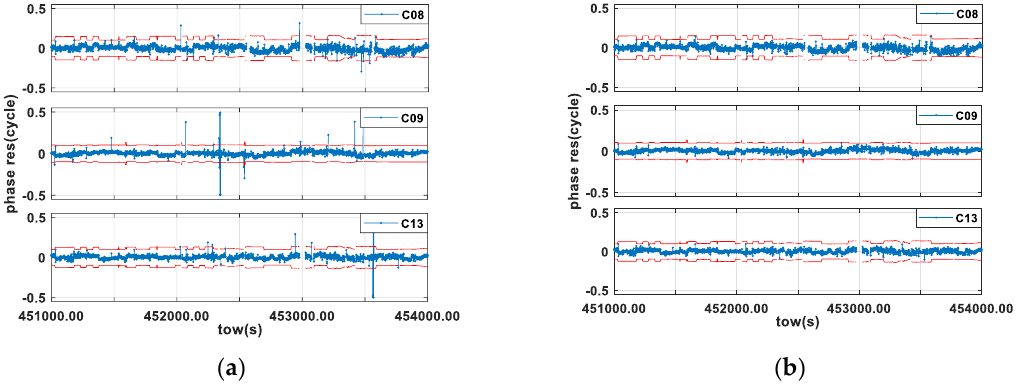
Figure 5. Residuals of carrier phase in real experiment: ( a ) prediction residuals of carrier phase; ( b ) residuals of the retained carrier phase measurements by MAQC method. The rea lines symbolize threshold value. The blue lines symbolize the residuals.